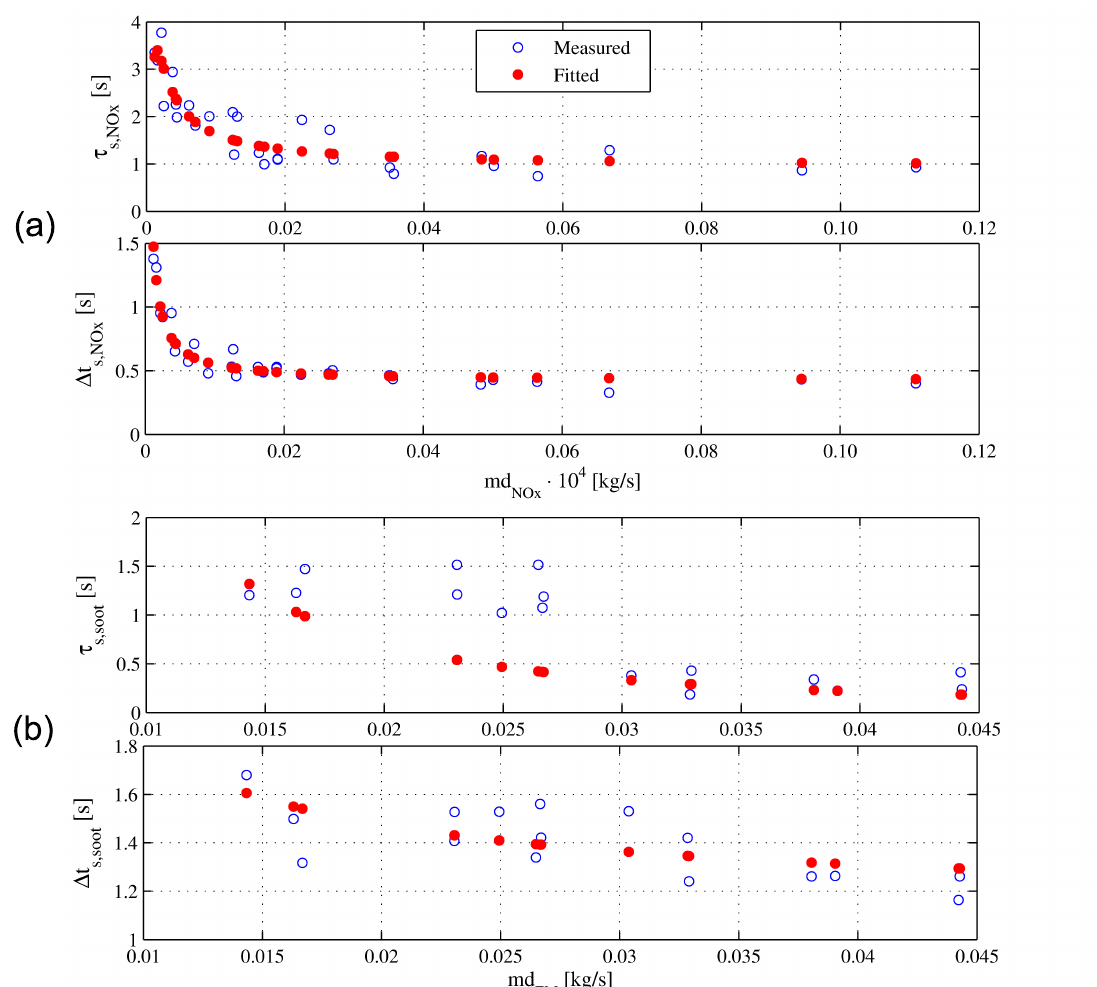
Figure 5. Trend of the time constant τ sensor; and ( b ) soot